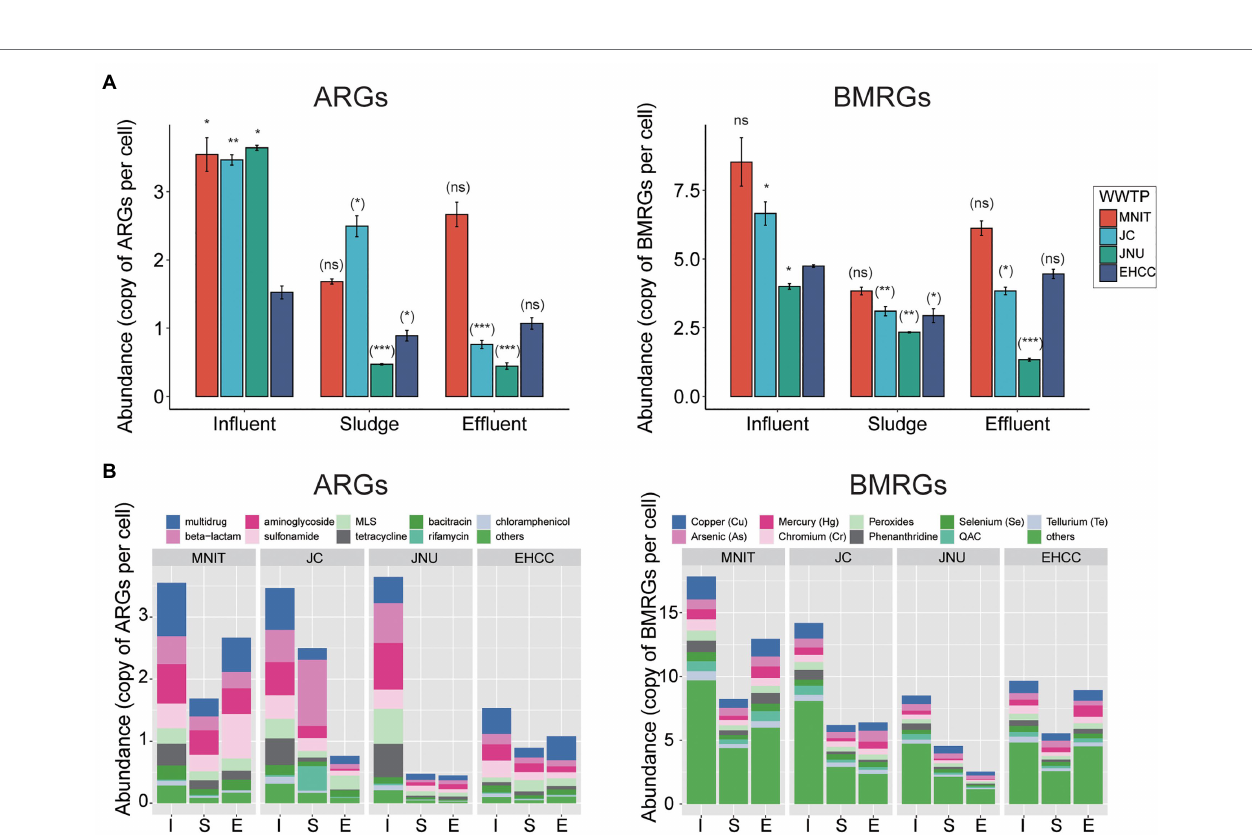
FIGURE 2 | Principal coordinate analysis (PCoA) of ARGs (A) and BMRGs (B) and heatmap of Spearman correlation among influents of four WWTPs. Both analyses were based on ARGs/BMRGs subtypes.